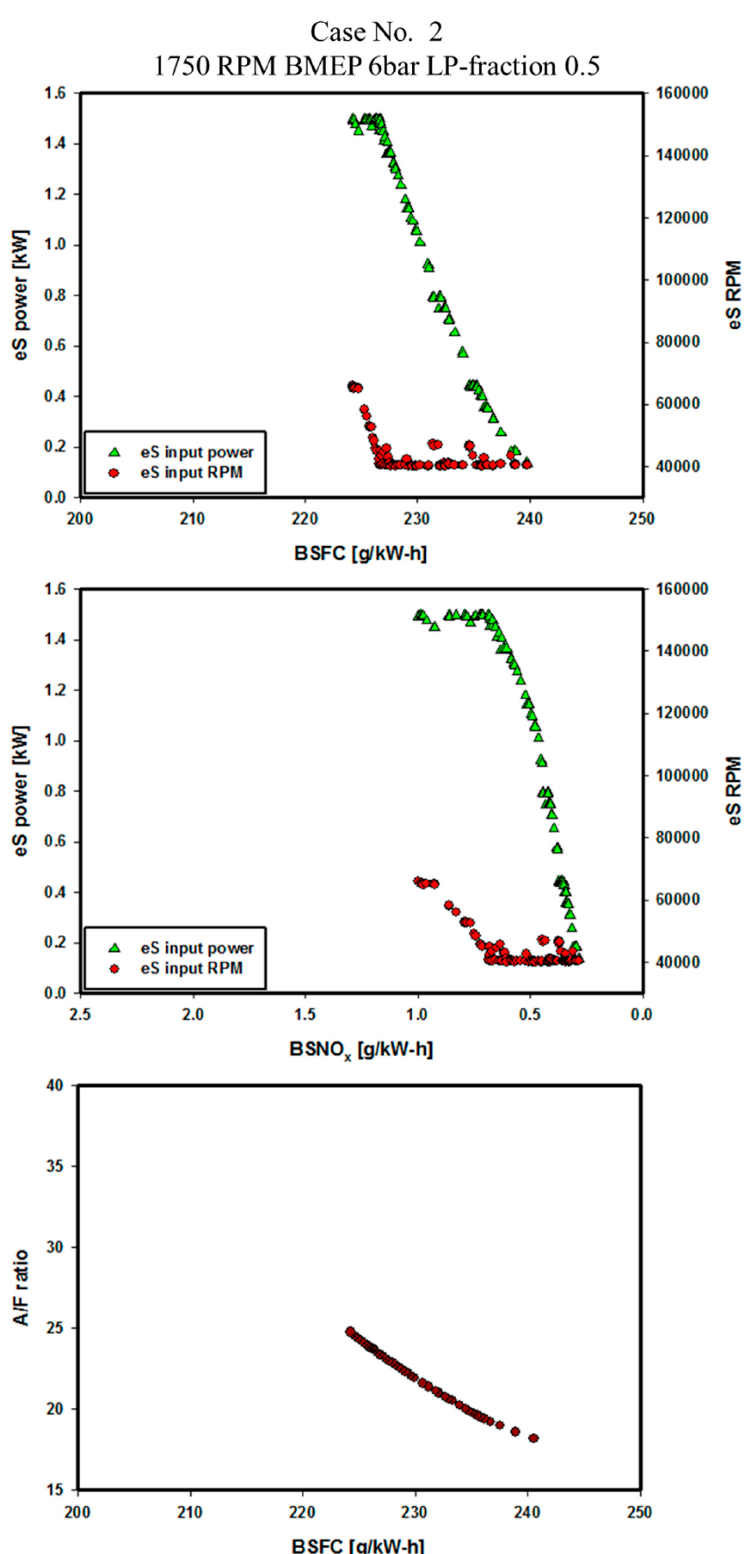
Figure 13. BSFC, BSNO x , and A/F ratio difference on the Pareto front line of case 2 (LP fraction = 0.5).